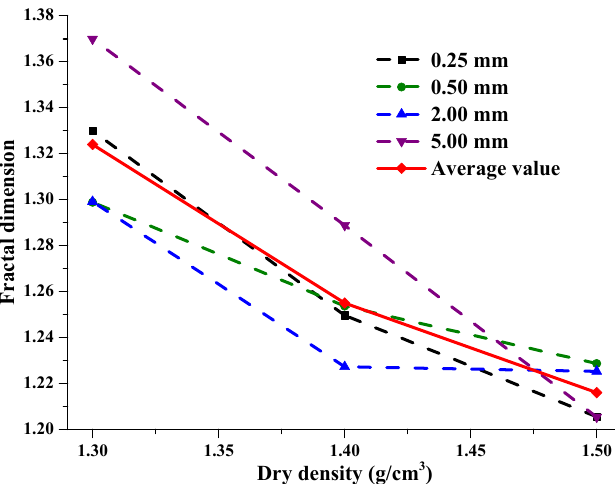
Figure 19. The fitting curve of dry density and total porosity.